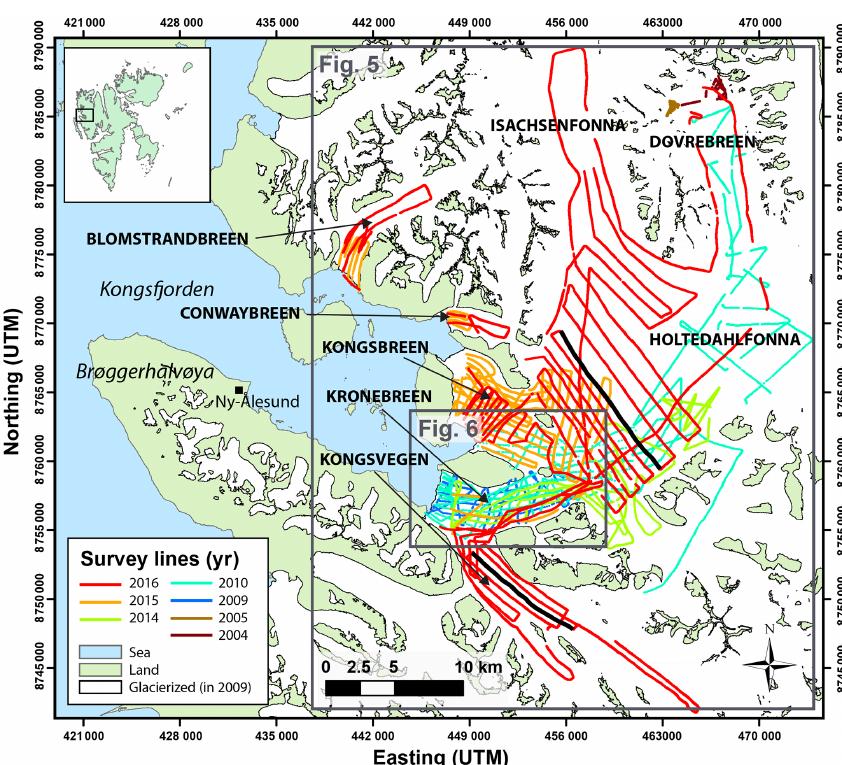
Figure 1. Radar survey lines collected between 2004 and 2016. Kongsfjorden, tidewater glaciers, icefields, the peninsula Brøggerhalvøya, and the research town Ny-Ålesund are marked in the map. The small inset map shows the location of Kongsfjorden in Svalbard. The blue areas are sea, green areas are land, and white areas are glacierized regions (in 2009). The black lines indicate the location of the profiles in Fig. 4 and the boxes show the coverage of Figs. 5 and 6. Grid projection is Universal Transverse Mercator Zone